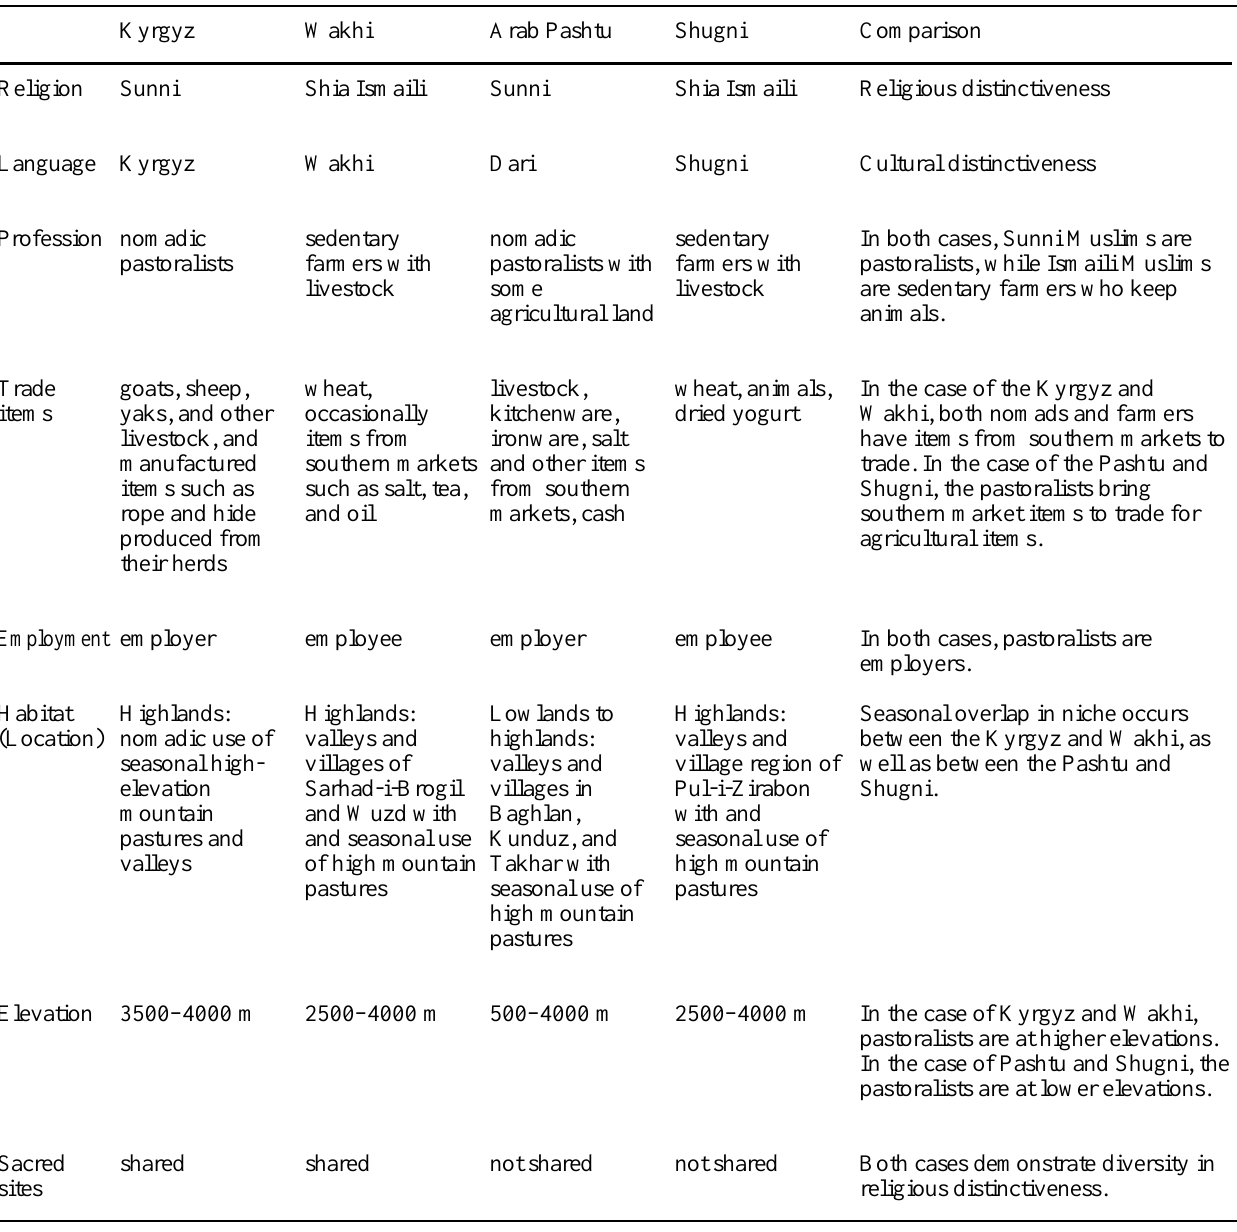
Table 1 . Comparative summary of two case studies (Kyrgyz and Wakhi, Arab Pashtu and